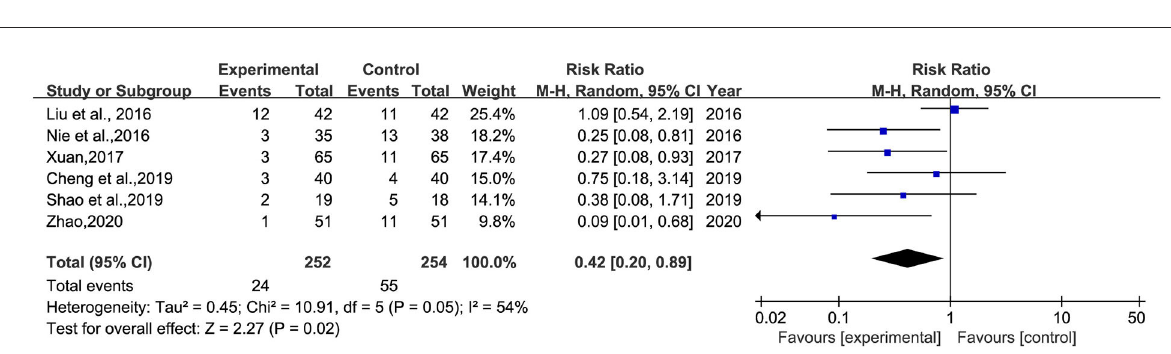
FIGURE8 Meta-analysis of BHD and antidepressant drugs regarding the incidence of adverse reactions. Blue: Dichotomous.